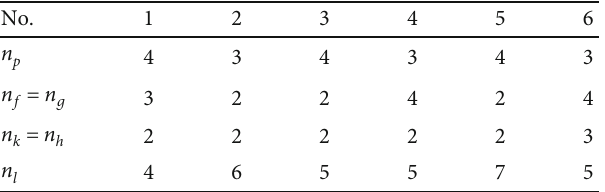
Table 4: Setting of the terms for the rendezvous trajectory of asteroid